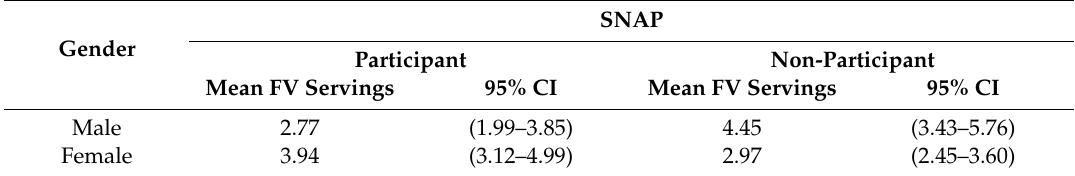
Table 3. Mean FV servings by SNAP participation.